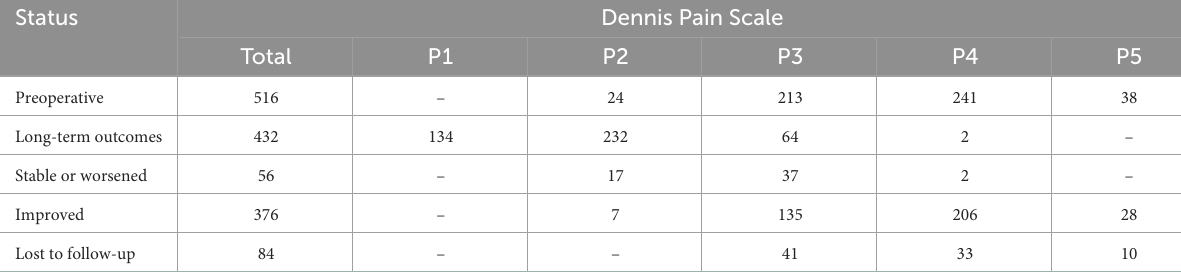
TABLE 2 Postoperative pain improvement of the patients.